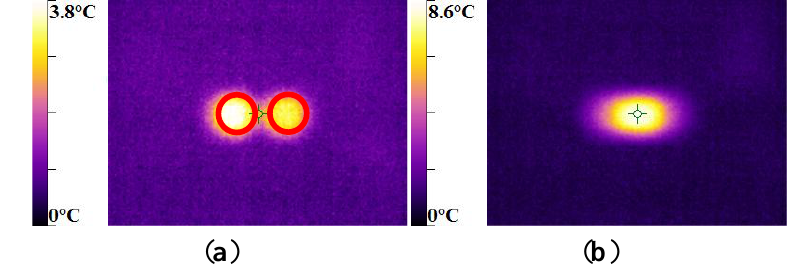
Figure 22. IR Thermographs of PC torsion test for V = 12 rad/min. a ) γ = 0.41 rad; ( b ) γ = 0.68 rad; ( c ) γ = 0.97 rad; and ( d ) γ = 1.29